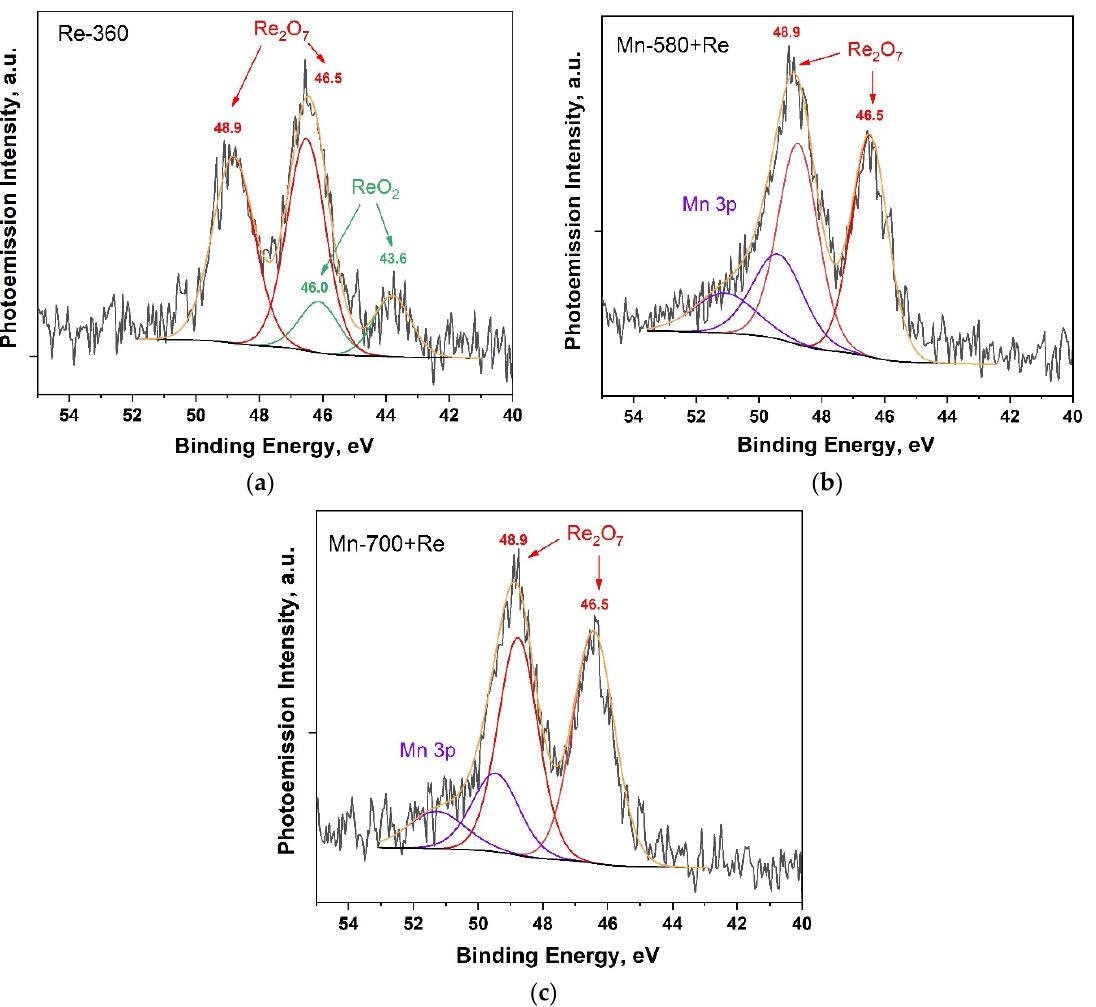
Figure 5. Re 4f PE spectra of composites: Re-360 ( a ); Mn-580 + Re ( b ); and Mn-580 + Re ( c ).